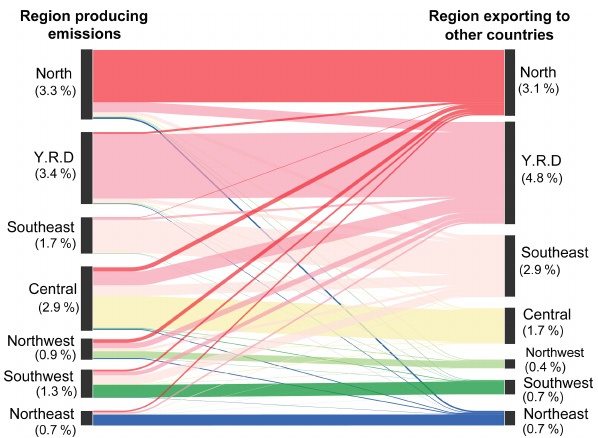
Figure 4. Flow map of premature deaths connecting producers and international exporter of finished products. The percentage values are relative to national total anthropogenic PM 2 . 5 -related premature deaths (1.02